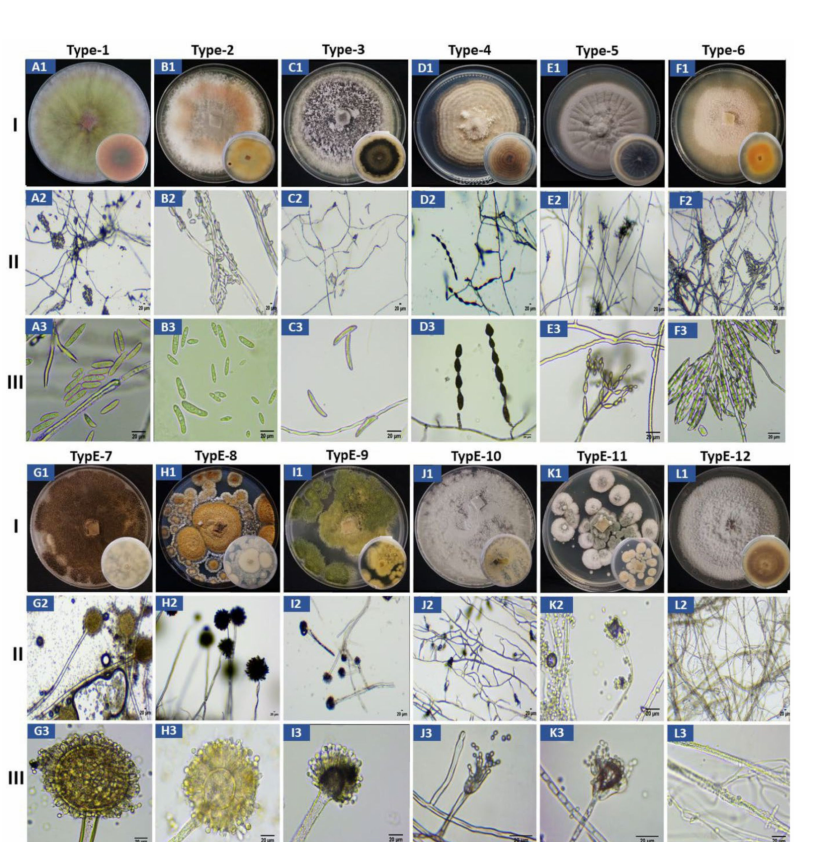
Figure 2. Morphological characterization of passion fruit isolates type-1 to type-12; I ( A1 – L1 ) colony morphology on PDA media, II ( A2 – L2 ) thread like structure showing hyphae and mycelium and III ( A3 – L3 ) conidia. Type-1 ( A1 – A3 ) = Fusarium kyushuense ; type-2 ( B1 – B3 ) = Fusarium concentricum